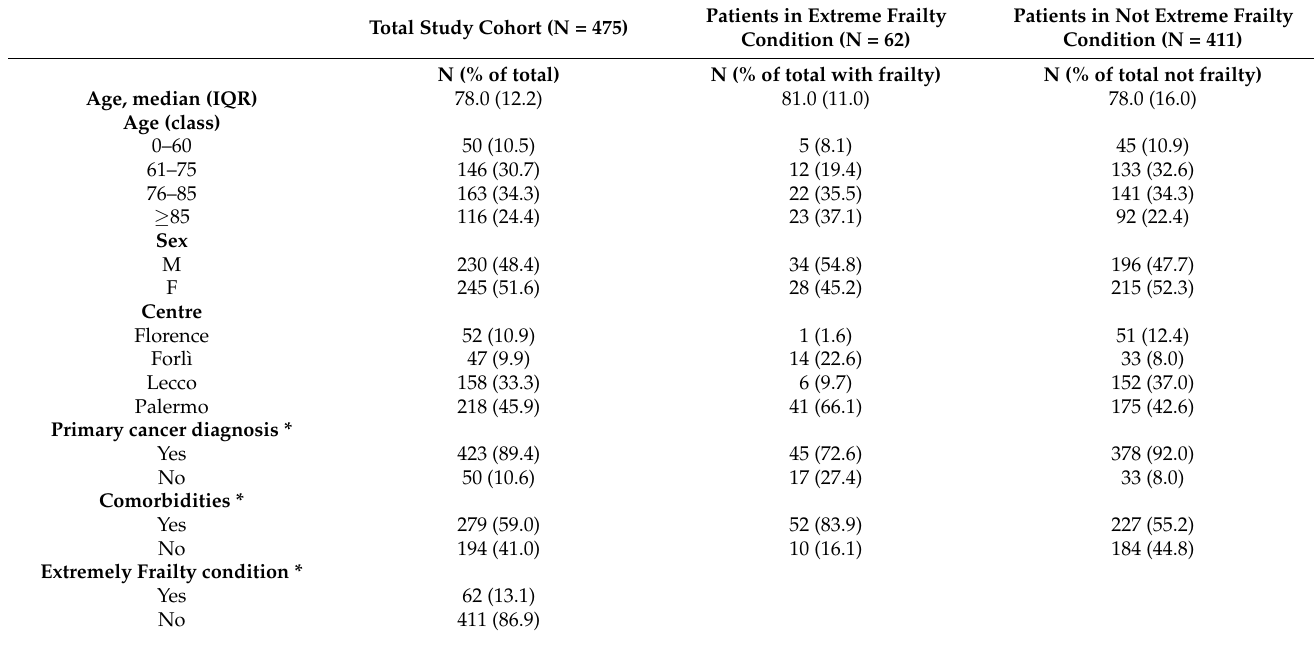
Table 2. Baseline characteristics of patients involved in the study, overall and stratified for the presence of factors of extreme